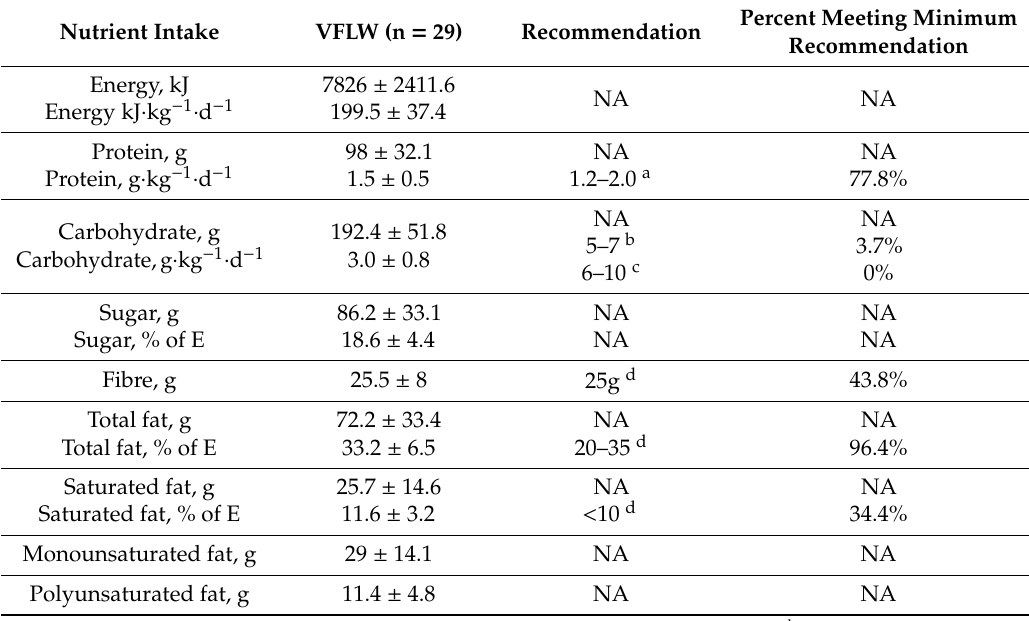
Table 2. Macronutrient intake of VFLW players (mean ± SD) and current